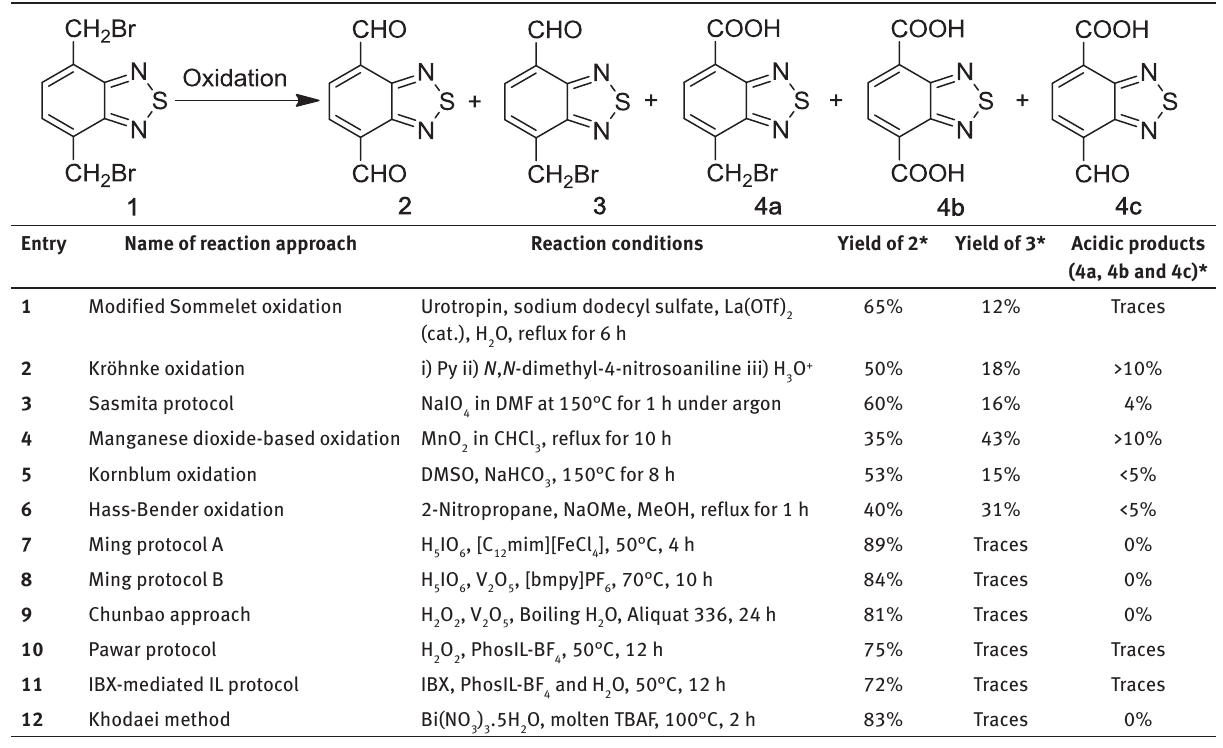
Table 1: Application of different oxidative protocols for synthesis of dialdehydes from organic dihalides.